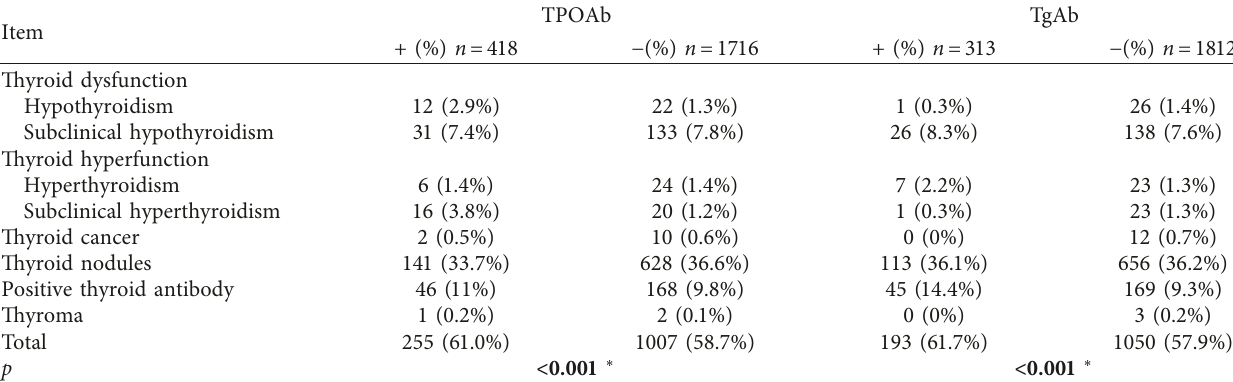
Table 5: The difference of thyroid disease between recessive and positive autoantibody